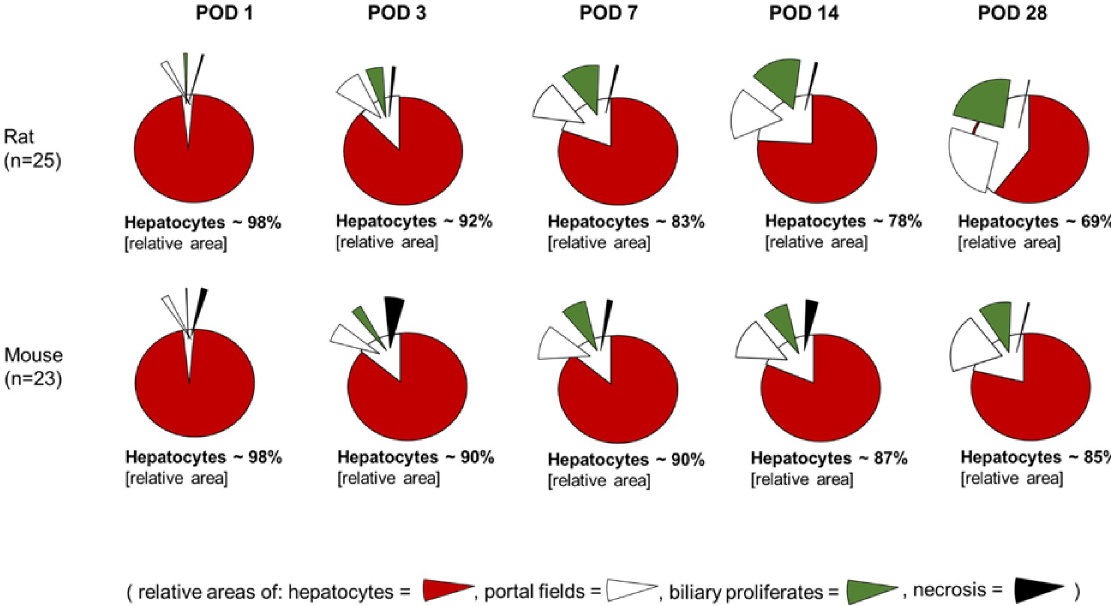
Fig 2. Morphometric alterations of liver tissue compartments (using relative areas of hepatocytes, portal fields, biliary proliferates and necrotic area) in rat and mouse at different time points after